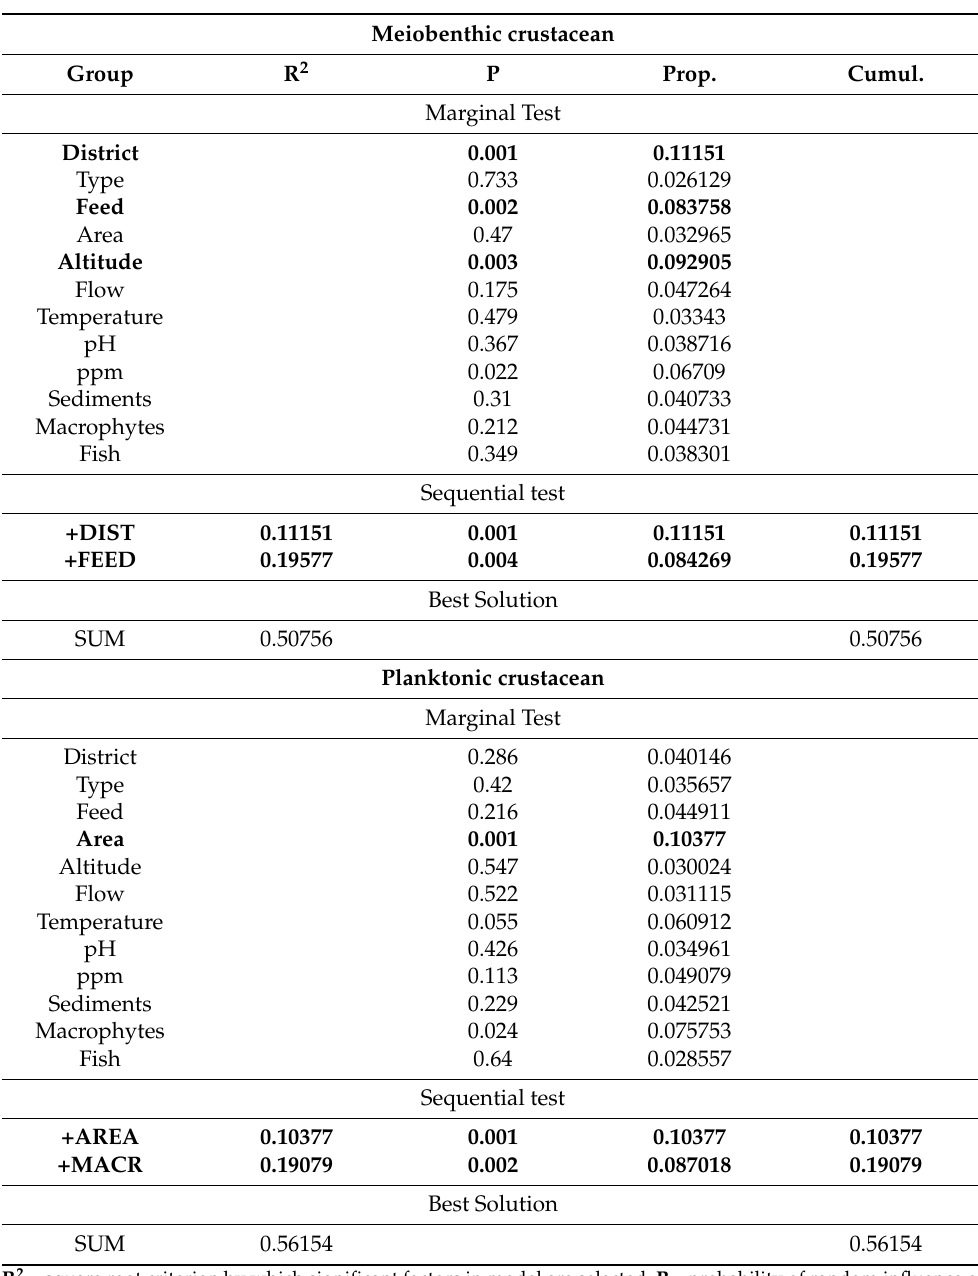
Table 2. The results of marginal and sequential tests of DistLM (AIC criterion, step-wise selection). Significant factors are in bold ( p < 0.02).